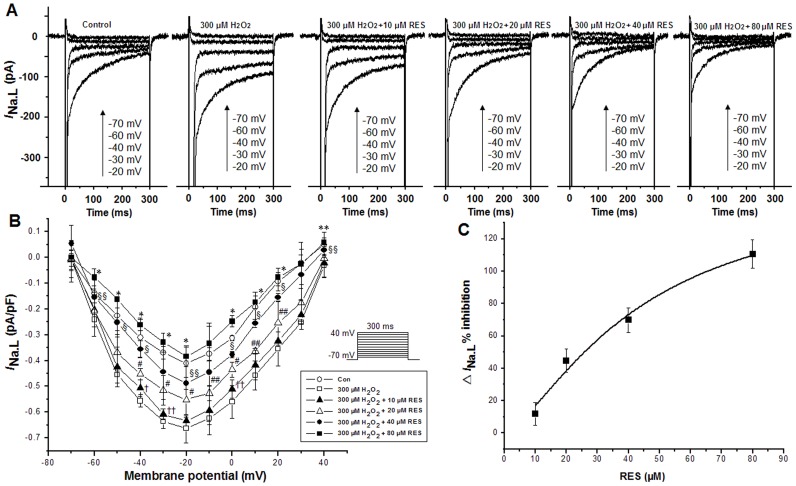
Resveratrol inhibited the increase in I
Na.L induced by 300 µM H2O2.
A. 10, 20, 40 and 80 µM resveratrol decreased the amplitudes of I
Na.L in the presence of 300 µM H2O2 in a concentration dependent manner. B. The I-V relationships of I
Na.L after the sequential application of 300 µM H2O2, 10, 20, 40 and 80 µM resveratrol. C. the inhibition amounts of 10, 20, 40 and 80 µM resveratrol on the △I
Na.L induced by 300 µM H2O2. Values are expressed as mean ± SD, n = 8 cells/group. †P<0.01, ††P<0.05 versus H2O2 group; #P<0.01, ##P<0.05 versus 10 µM resveratrol group; §P<0.01, §§P<0.05 versus 20 µM resveratrol group; *P<0.01, **P<0.05 versus 40 µM resveratrol group.